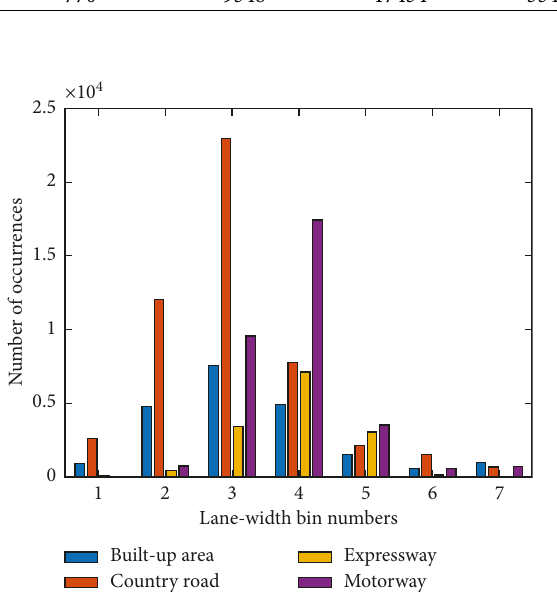
Expressway Motorway